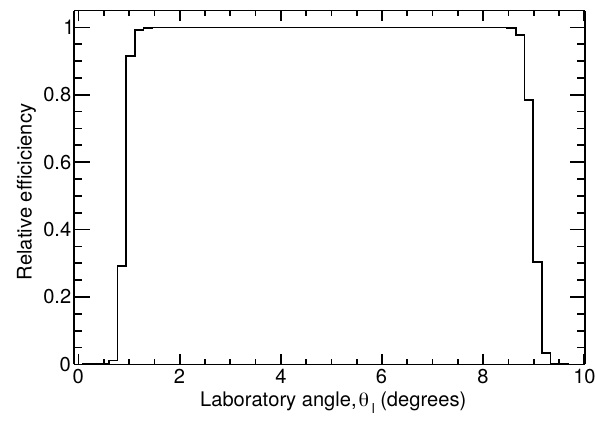
Figure 2. The transport e ffi ciency of SOLITAIRE as a function of laboratory angle demonstrating the high e ffi ciency for parti- cles that are not stopped from entering the